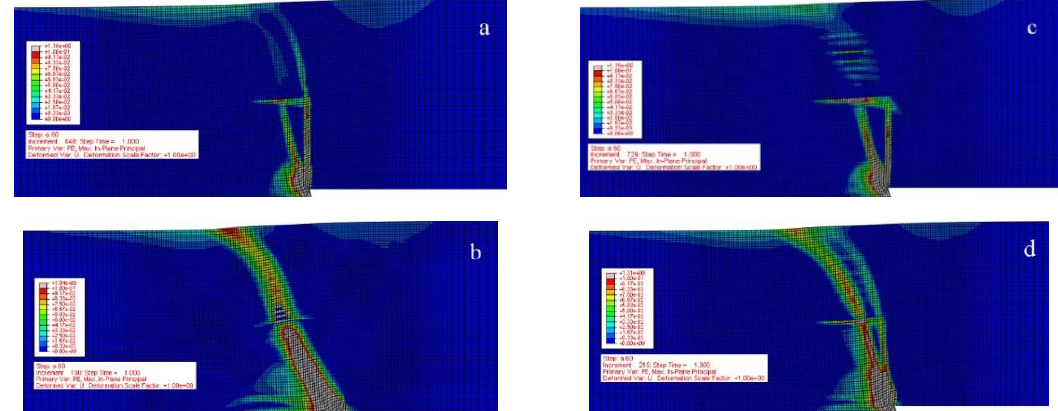
Fig. 10. Comparison fault route angle for two soil layers with different densities: (a) MS-LS, (b) MS-DS, (c) DS-LS and (d) DS-MS.